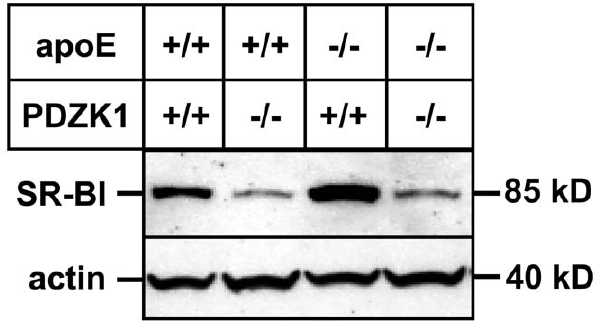
Figure 1. Immunoblot analysis of hepatic SR-BI expression. Mice with the indicated genotypes were fed a high fat/high cholesterol/ cholate-containing ‘‘Paigen’’ diet for three months. Livers were harvested and subjected to immunoblotting using anti-SR-BI and anti-actin (loading control) antibodies as described in Materials and Methods.